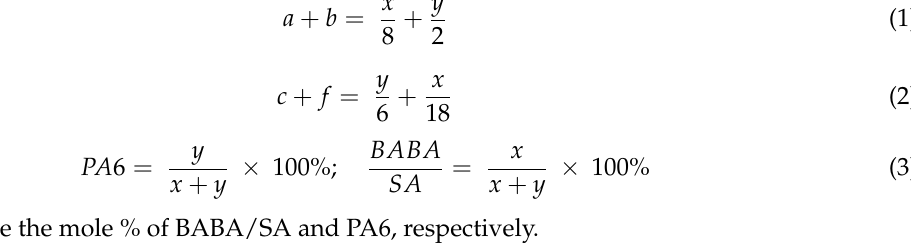
Table 1. Characteristics of virgin PA6 and PA6-BABA/SA prepared by melt polymerization. Monomer Feed, wt % Built-in Samples ratio (CPL/BABA/SA) a wt %